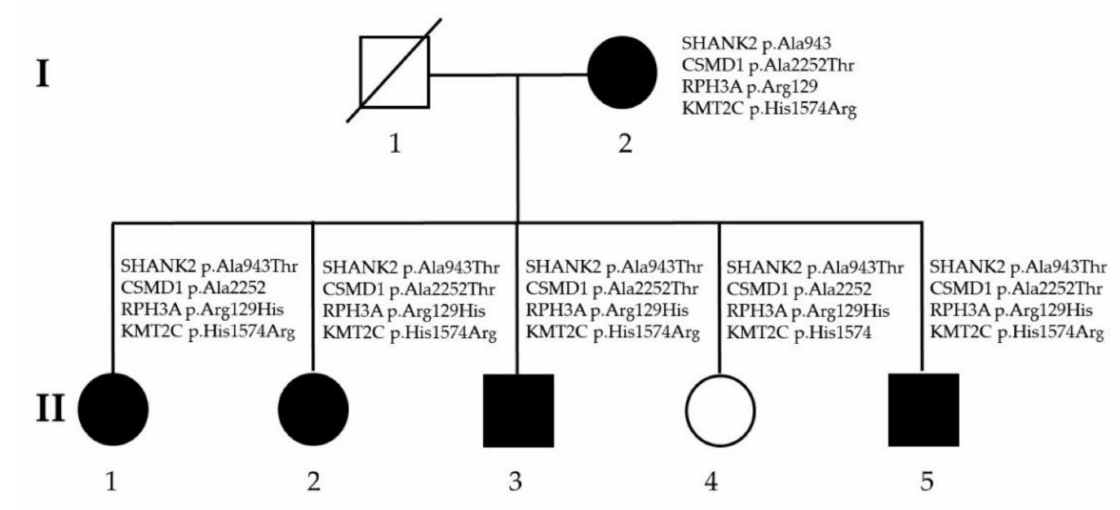
Figure 2. Family analysis of four rare, likely pathogenic mutations identified in this study.